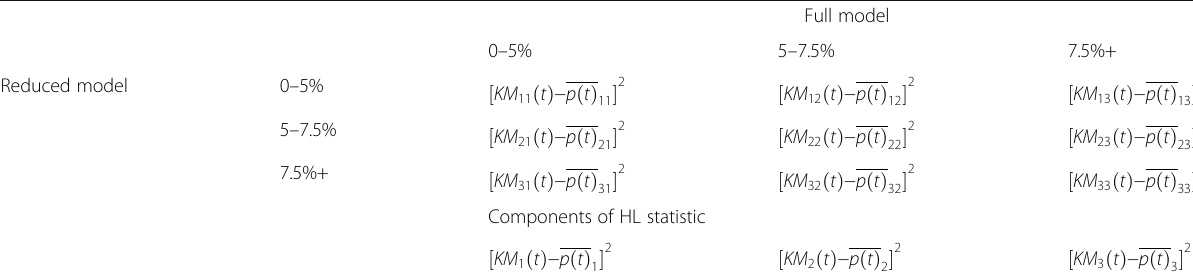
Table 4 Building blocks of HL and RC statistics